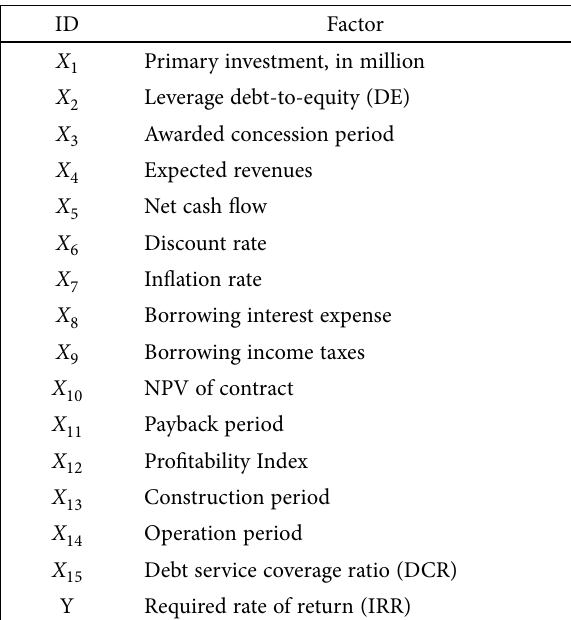
Table 2. Financial data attributes of PPPs